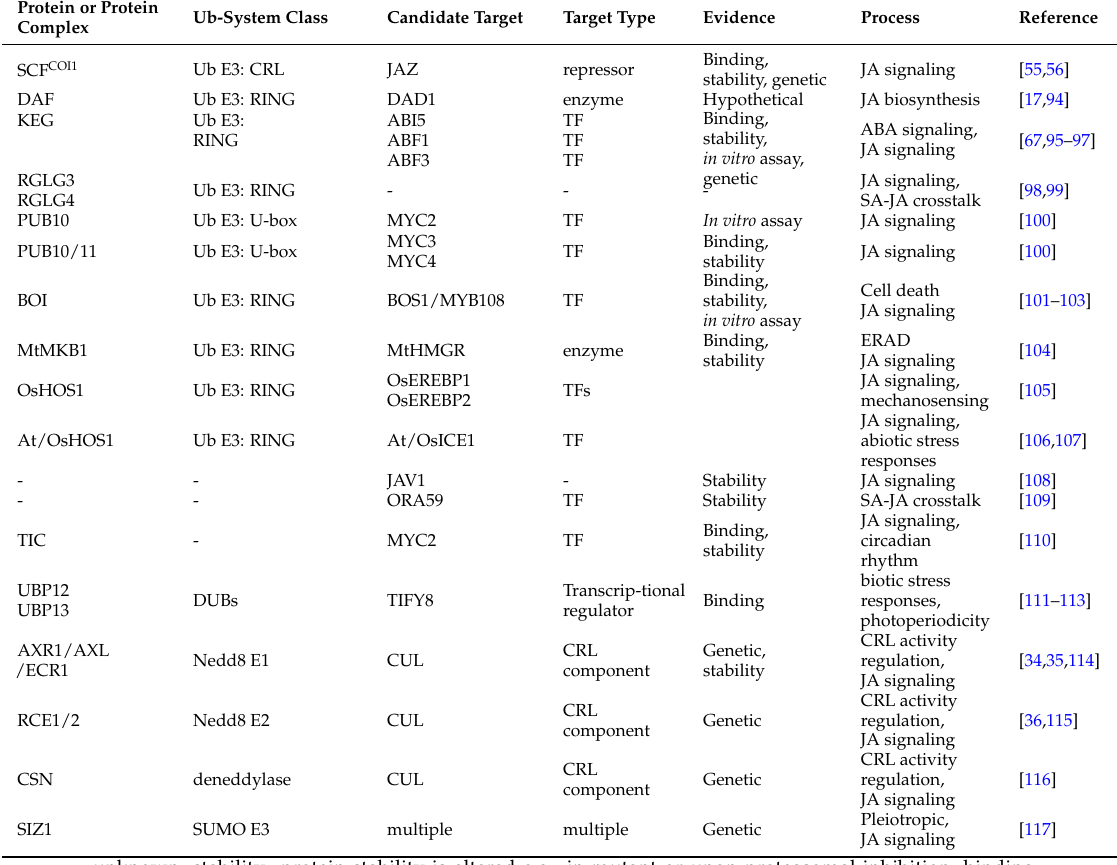
Table 1. Overview of Ub-system components with a role in jasmonic acid (JA) signaling. Protein or Protein